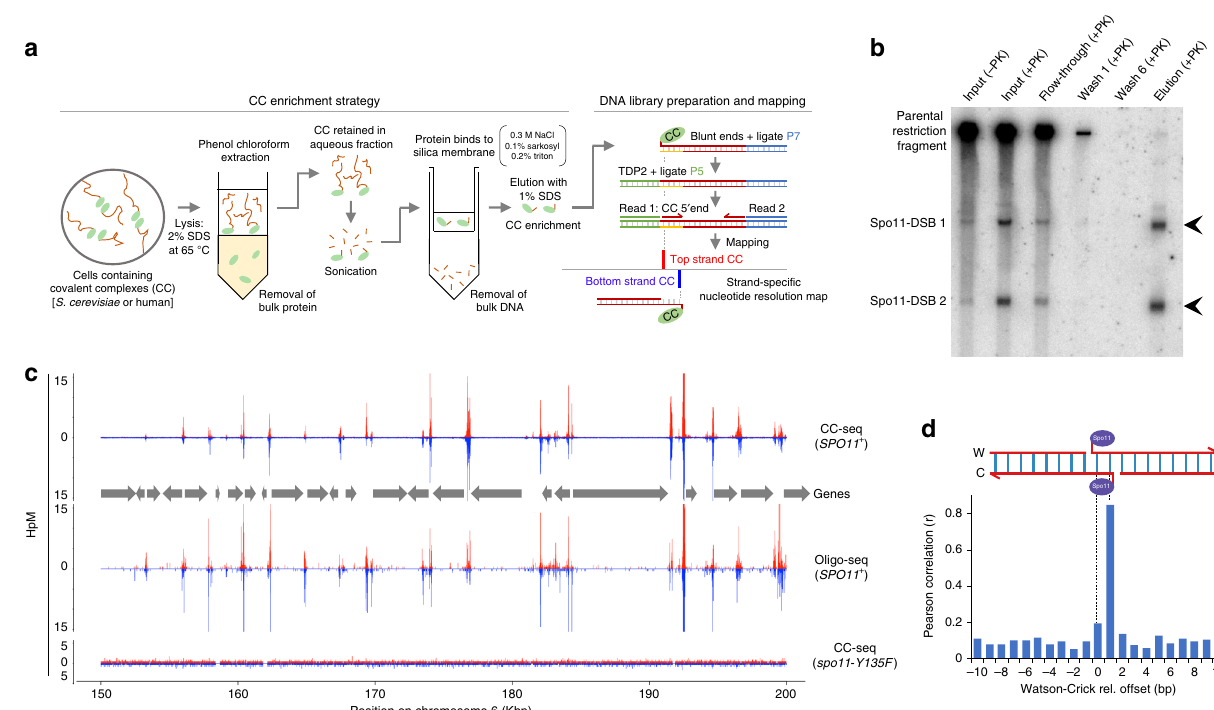
Fig. 1 CC-seq maps covalent Spo11-linked DNA breaks in S . cerevisiae meiosis with nucleotide accuracy. a Schematic of the CC-seq method. b Silica-based enrichment of meiotic S . cerevisiae Spo11-linked DNA fragments detected by Southern blotting at the his4 :: LEU2 recombination hotspot. Arrowheads indicate expected sizes of Spo11-DSBs. ‘ + PK ’ = samples treated with proteinase K prior to electrophoresis. The eluate was loaded at 4X cell equivalents relative to the input. c Nucleotide resolution mapping of meiotic S . cerevisiae Spo11 hotspots by CC-seq or oligo-seq 28 . Red and blue traces indicate Spo11- linked 5 ′ DNA termini on the Watson and Crick strands, respectively. Grey arrows indicate positions of gene open reading frames. d Pearson correlation (r) of Spo11 CC-seq signal between Watson and Crick strands, offset by the indicated distances. Cartoon shows the known Spo11-DSB structure. HpM Hits per million mapped reads per base pair. Source data are provided as a Source Data fi